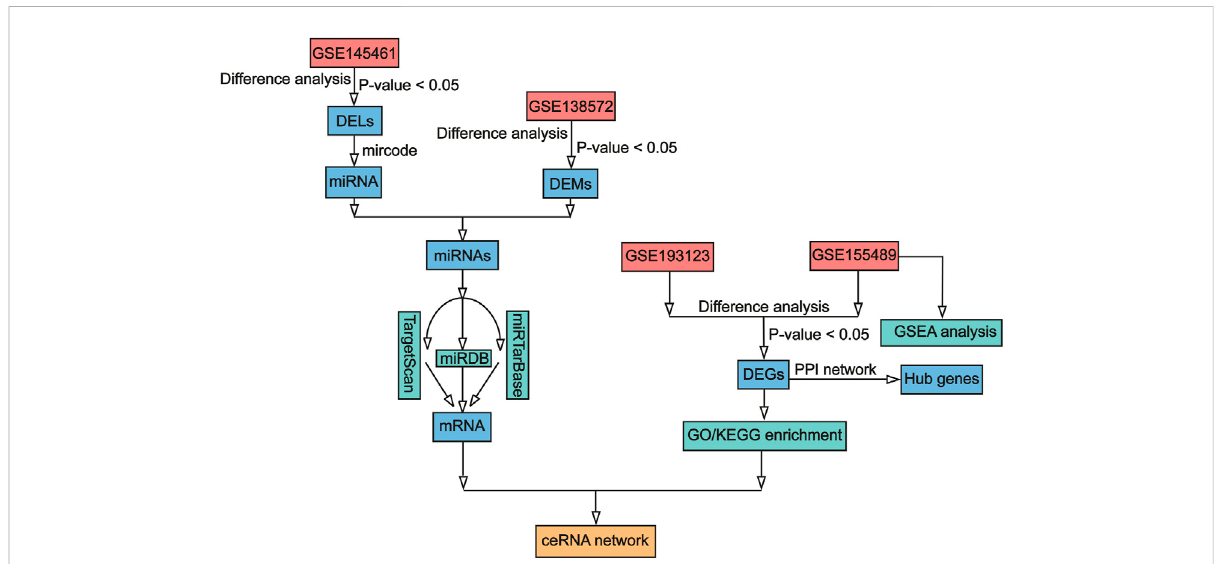
FIGURE 1 Work fl ow of data processing and analysis. DEL, Differentially expressed lncRNA; DEM, differentially expressed miRNA; DEG, differentially expressed mRNA; lncRNA, long non-coding RNA; miRNA, microRNA; mRNA, messenger RNA; GO, Gene Ontology; KEGG, Kyoto Encyclopedia of Genes and Genomes; GSEA, gene set enrichment analysis; ceRNA, competing endogenous